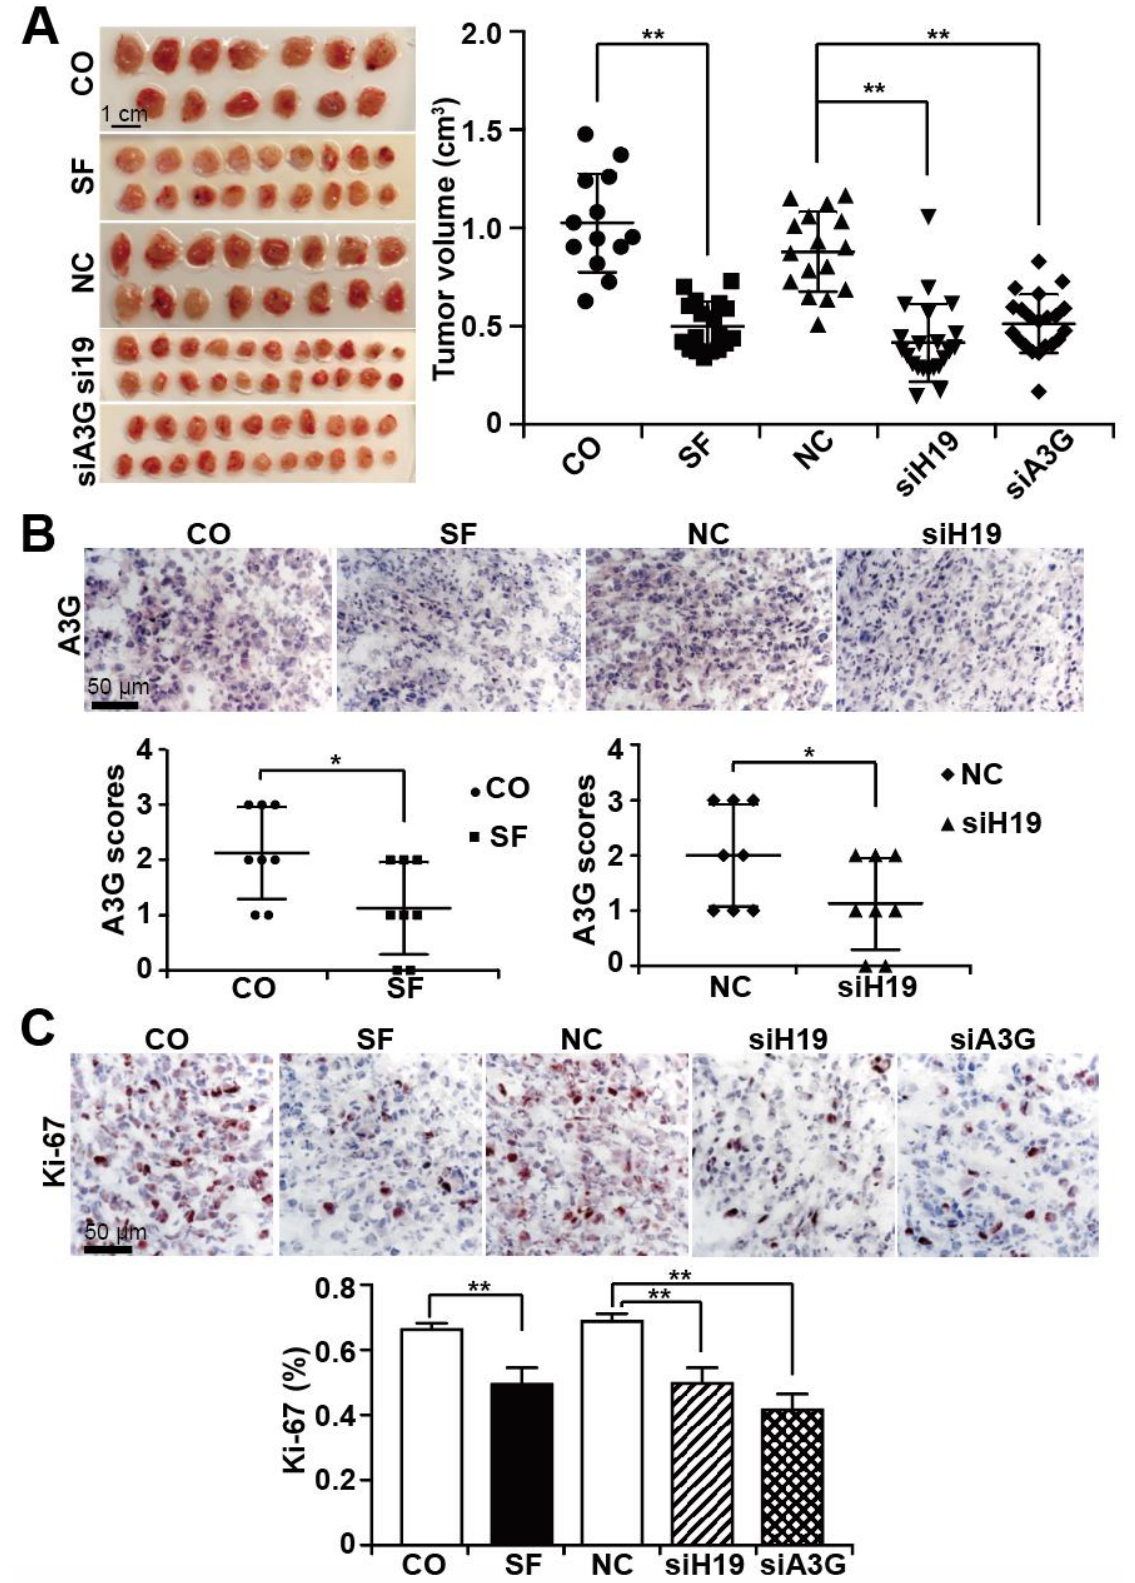
Figure 6. Sulforaphane mimics the effects of H19 or A3G downregulation in vivo. ( A ) MIA-PaCa2 cells were transfected with nonsense siRNA control (NC), H19 siRNA (siH19), or A3G siRNA (siA3G). Twenty-four hours later, 10 6 cells in 50 µ L Matrigel TM , were transplanted onto the CAM of fertilized chicken eggs on chick developmental day 9. At day 14, 100 µ L of a 100 µ M sulforaphane (SF) solution or 100 µ L saline (CO) was injected directly into the CAM vessels that supplied